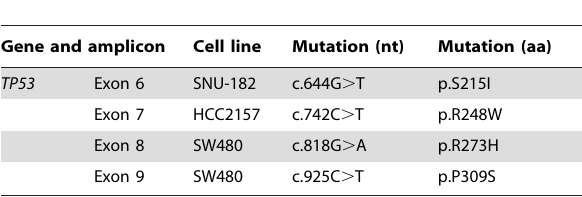
Table 1. Cell lines used in the present